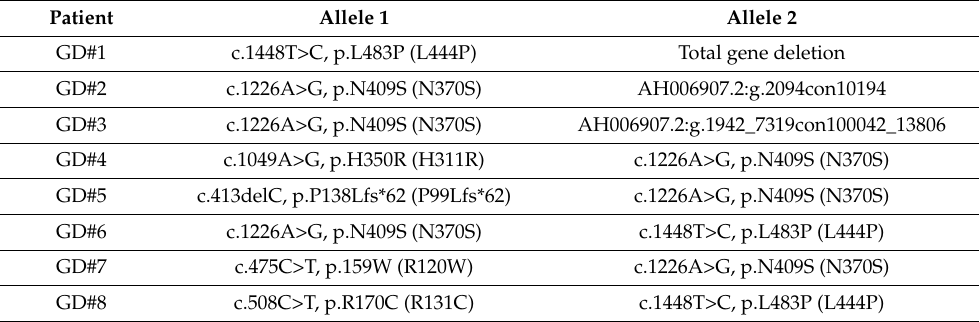
Table 1. GBA gene mutations identified in GD